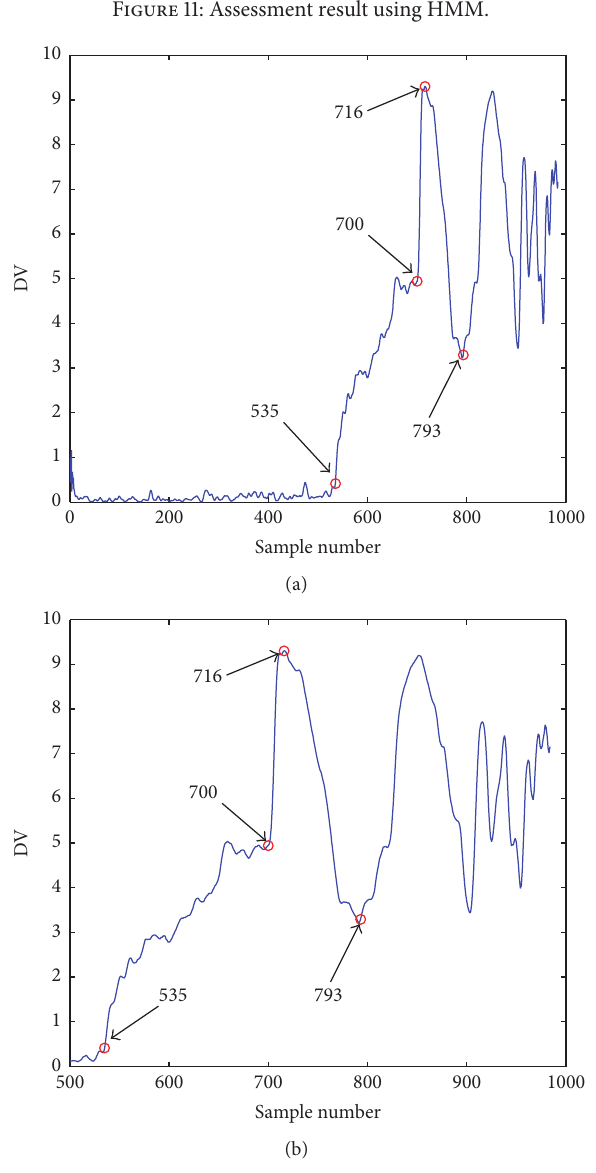
Figure 12: Assessment result using LWPE and SVDD. (a) Life-cycle assessment result of bearing 1. (b) Dramatic local enlargement of (a).